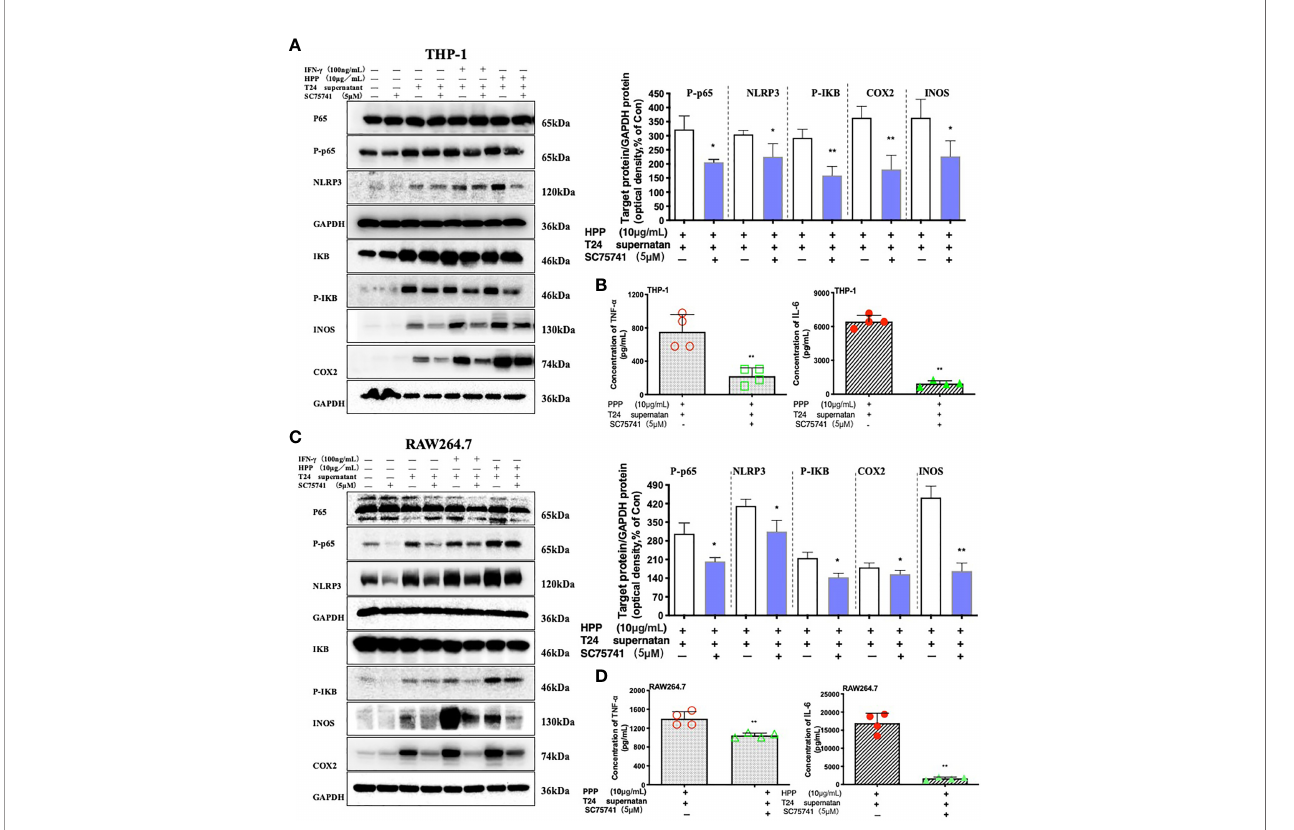
FIGURE 7 | Effect of a speci fi c NF- k B inhibitor on macrophages treated with HPP. (A, C) Effect of HPP on NF- k B in RAW 264.7 or THP-1 macrophages. Phospho- P65-NF- k B, NLRP3, phospho-I k B, INOS, and COX-2 were determined using western blotting. (B, D) In fl ammatory cytokine secretion in macrophages. Values are given as the mean ± SD from three independent experiments. Compared with the control group, # P < 0.05; compared with the RAW 264.7+T24 control group, * P <